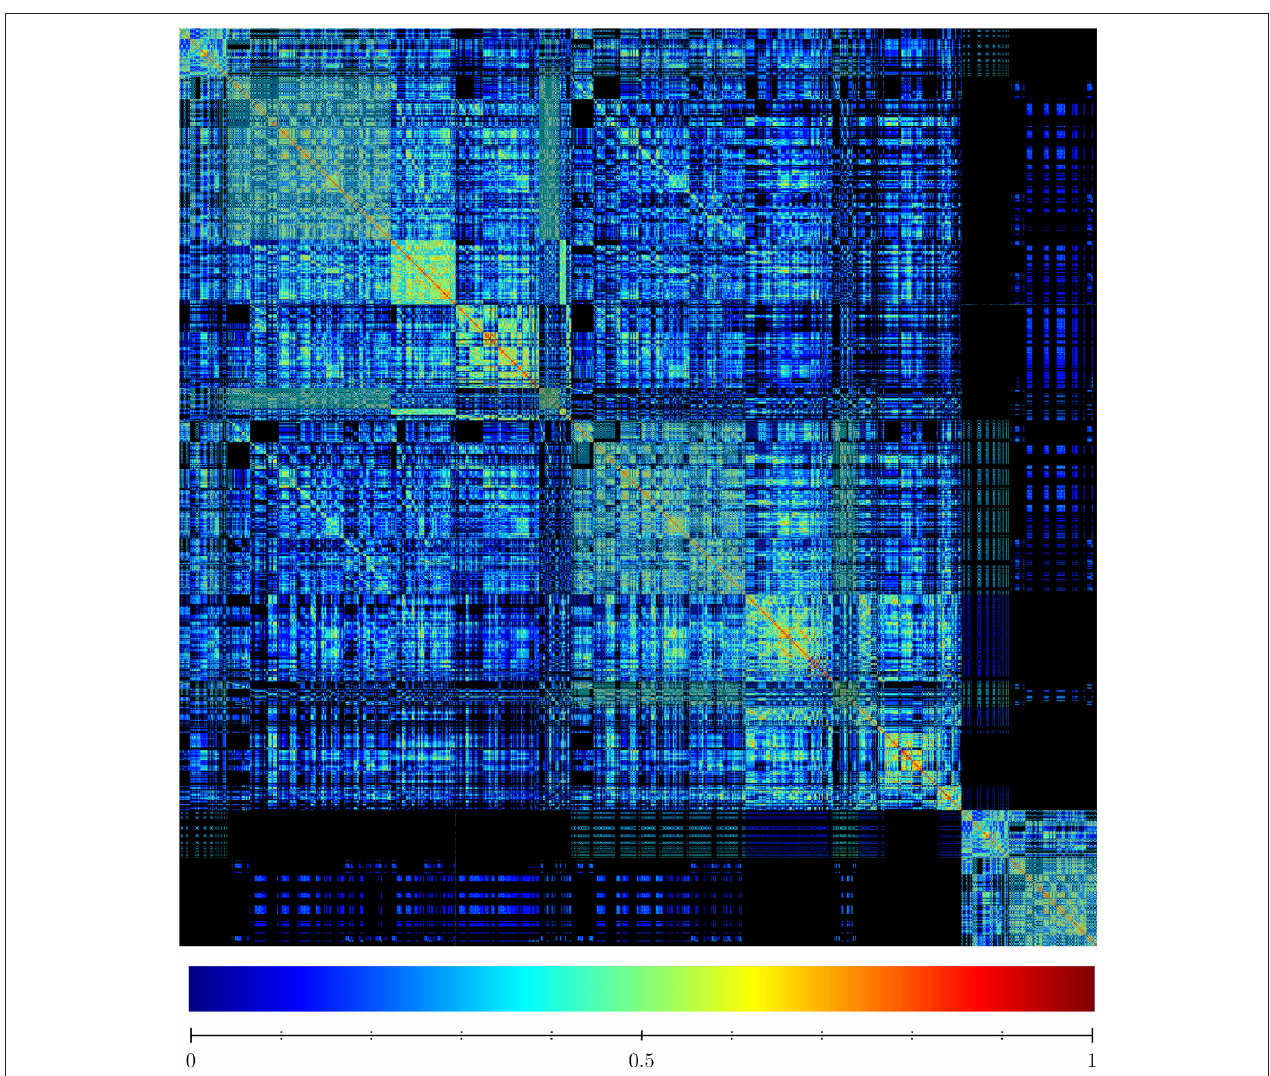
FIGURE 5 | Similarity matrix of sets of fixed-point attractors for a sample of 2,896 Boolean networks satisfying the interaction graph of A. thaliana flower model shown in Figure 3A and that do not have cyclic attractors. The similarity matrix shows the degree to which different sets of fixed-point attractors share the same elements. Each row and column represents a particular witness. The entry ( i , j ) represents the similarity between the fixed-point attractor sets of witness i and witness j . The maximum similarity between two networks equals 1 if they have the same set of fixed-points. Algorithm 3 ensures that the witnesses have different sets of fixed-point attractors. Therefore, the only entries in the similarity matrix that are equal to one are in the diagonal. The minimum similarity between two networks is zero. This happens when the intersection of their sets of fixed-point attractors is empty. High values of similarity are colored red while low values of similarity are colored blue. Zero similarity corresponds to black. The similarity of two sets was found using the cosine similarity given by sim ( x , y ) = x · y k x kk y k where x and y are binary vectors encoding the presence or absence of different fixed-point